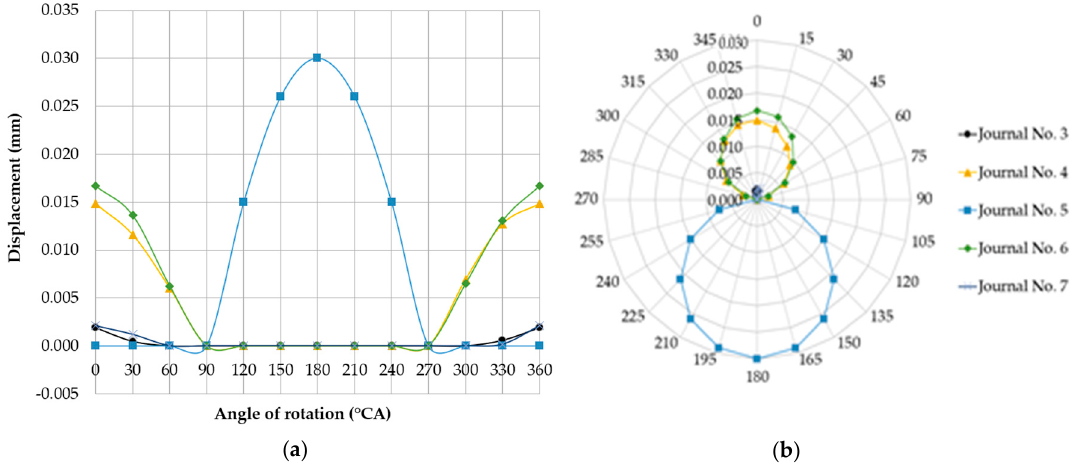
Figure 11. Changes in deflections measured in the vertical plane at individual main journals, when one of the main journal axes (no. 5 counting from the timing gear end) was offset eccentrically downwards by 0.03 mm relative to the others, shown in the ( a ) Cartesian and ( b ) polar coordinate systems.